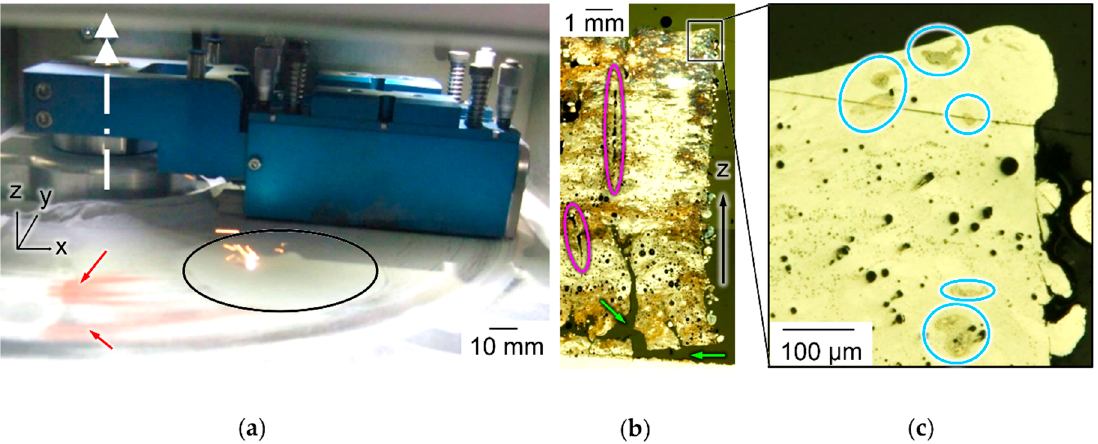
Figure 6. Challenges of in situ alloying Al-Cu powder mixtures in LBM, experimental establishment of initial situation with default parameters and PSD without SiO x ; ( a ) Cu segregation from thin powder layer inside LBM machine (red arrows), build platform (black), wiper axis (white); ( b ) etched section of LBM sample with irregular color, thin vertical defects (pink), delamination from platform (green arrows); ( c ) detail with incompletely melted Cu particles (blue) and spherical pores (dark).